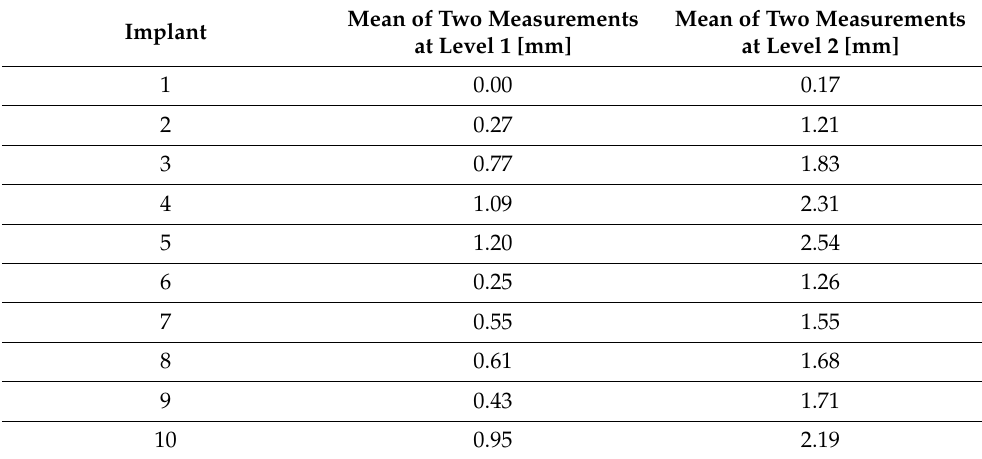
Table 1. Measurements on the scans at two bone